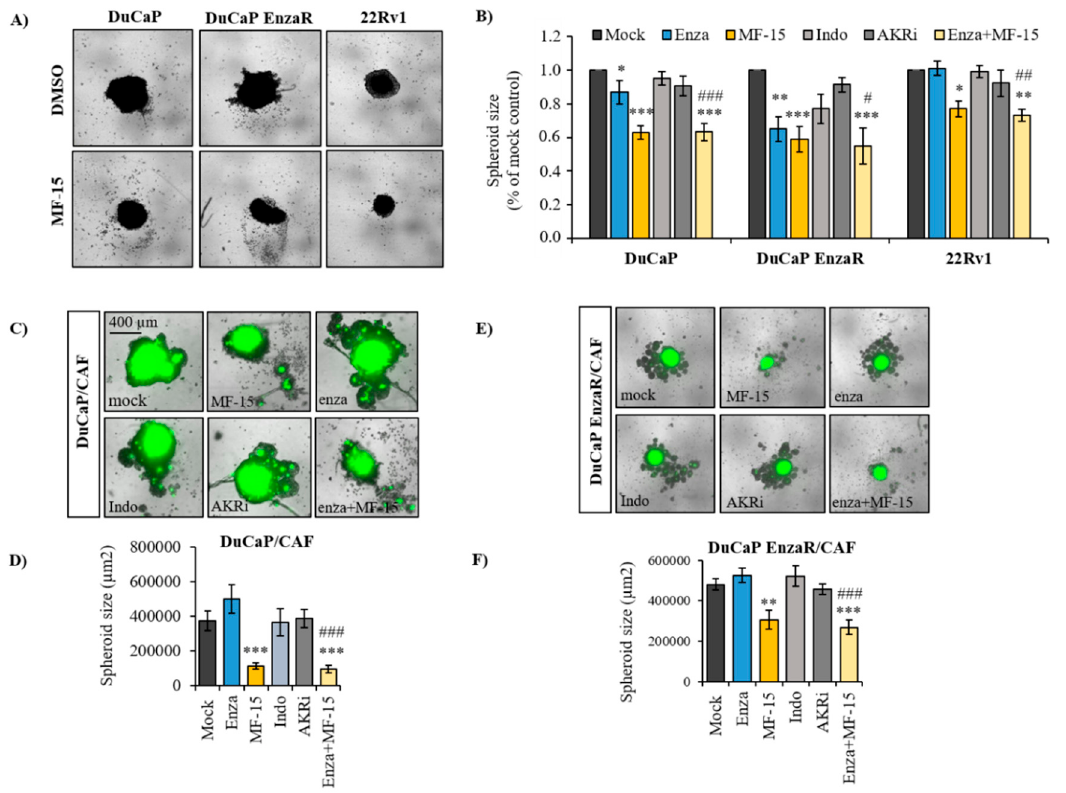
Figure 3. Anti-neoplastic e ff ects of MF-15 in prostate cancer spheroids. ( A ) 22Rv1, DuCaP, and DuCaP EnzaR (8000 cells per well) or ( C , E ) DuCaP and DuCaP Enza R with GFP-labeled CAFs at a ratio of 1:1 (4000 + 4000 cells per well) were seeded into ULC 96-well plates (Corning) and allowed to form spheroids over 4 days. MF-15 (10 µ M), indomethacin (indo, 20 µ M), AKRi (50 µ M), enzalutamide (5 µ M) and a combination of enzalutamide (5 µ M) with MF-15 (10 µ M) were added at days 4 and 8 in RPMI + 10% CS-FCS. ( B , D , F ) Spheroid size was determined at day 10, and ( A , C , E ) representative images were taken with IncuCyte S3 software. Data represent the mean ± SEM from three independent experiments. Statistical comparisons to the mock control were expressed with an asterisk (* p < 0.05, ** p < 0.01, *** p < 0.001) and comparisons to enzalutamide with a hash key (#).